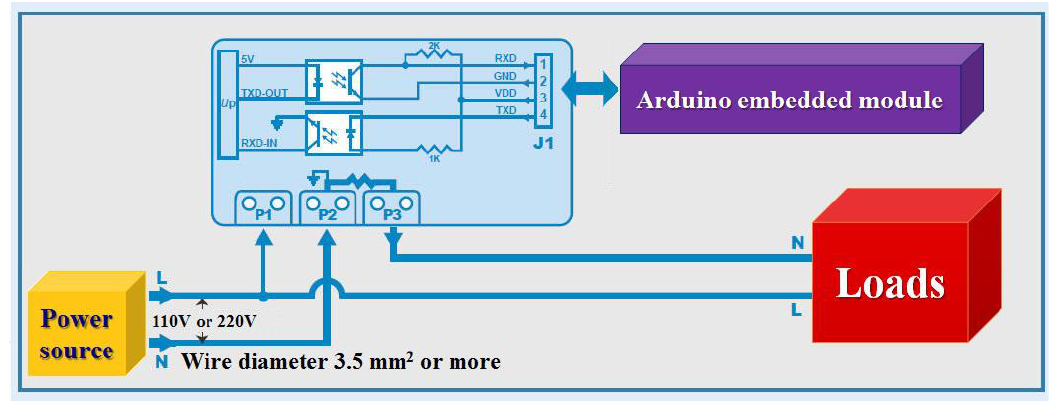
Figure 28. Actual connection with the diagram of each